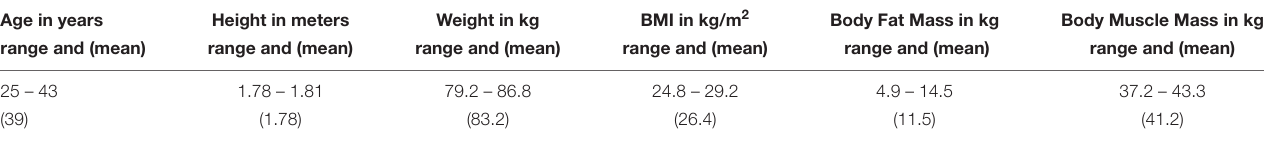
TABLE 1 | Demographics of the four study